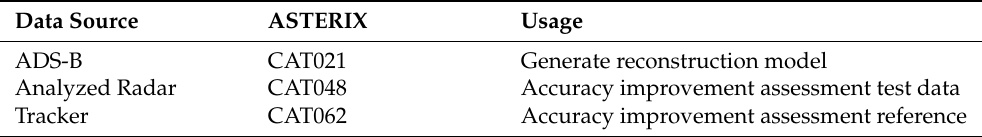
Table 4. ASTERIX Data Content and Usage in Dataset. Data Source ASTERIX